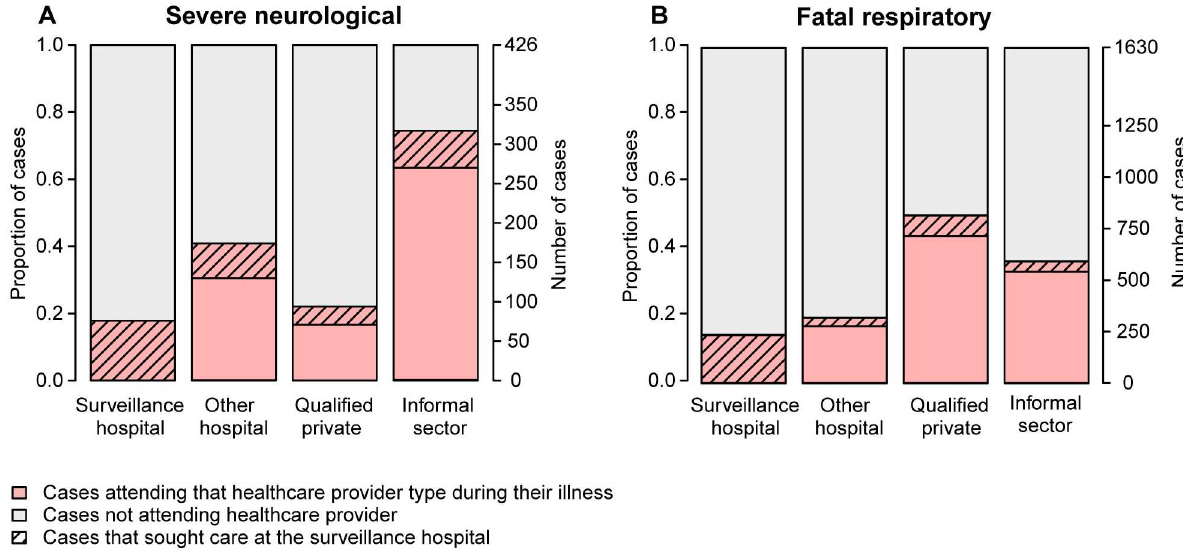
Fig 5. Attendance at surveillance hospitals and alternative healthcare providers. Proportionof (A) severe neurologicaland (B) fatal respiratory diseasecases attending surveillance hospitals and other healthcareproviders. Cases may attend severaldifferent healthcare providersduringtheir sickness. Cases who attendeda surveillancehospital at any time are indicatedwith diagonalhatching.